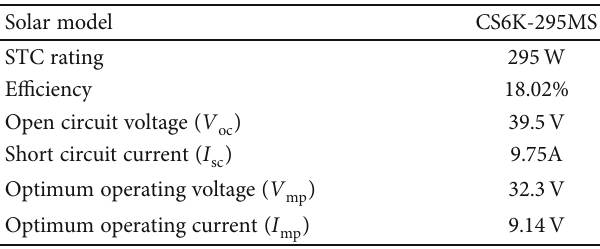
Figure 3: Global solar radiation with the corresponding clearness index at Kigali city, Rwanda (data gathered by NASA, Surface Solar Energy database, 2020). Table 2: Parameters of CS6K-295MS PV Module at Standard Test Conditions (STC) and temperature = 25 ° C and insolation = 1000 W/m 2 .